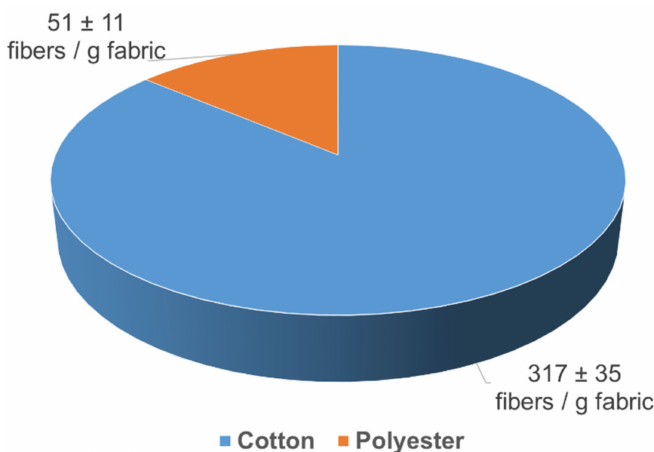
Figure 7. Fiber counts per g fabric of polyester and cotton fibers regarding the total amount of shedded fibers. These results refer to a wastewater sample from a washing process of a 50 / 50 polyester-cotton intimate blended fabric analyzed by dynamic image